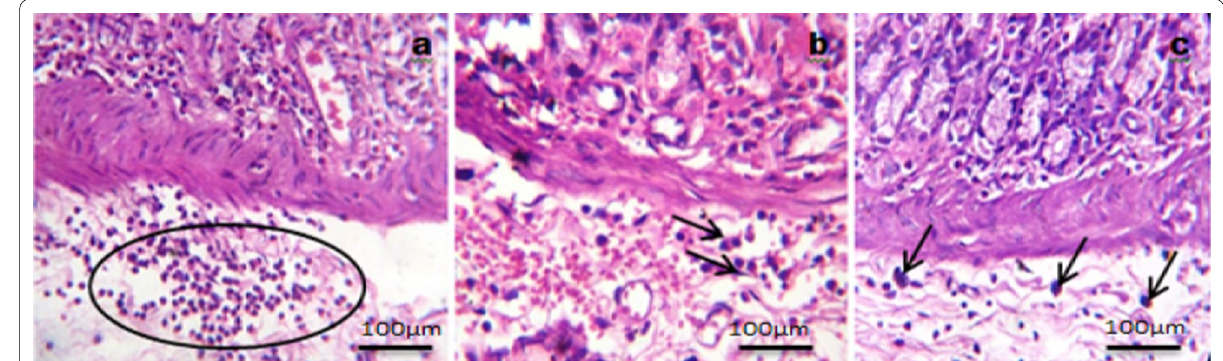
Fig. 5 Representative slides for evaluation of inflammatory cells infiltration in the pyloric ligated stomach ulcer pretreated with folic acid and omeprazole. (H&E, X100) a Pyloric ligated stomach with no treatment. b Pyloric ligated stomach treated with Folic acid. c Pyloric ligated stomach treated with Omeprazole. Black arrow and circled area: Inflammatory